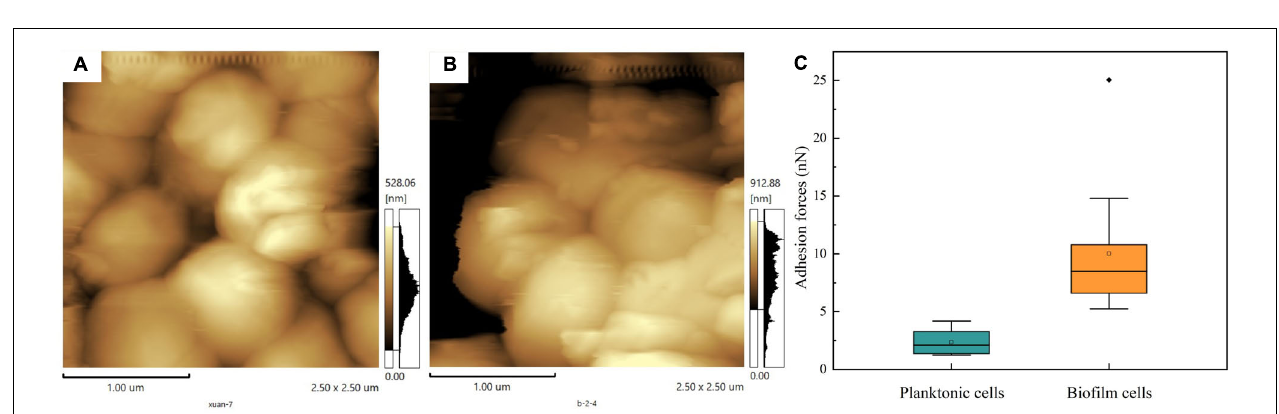
FIGURE 5 | Cell surface properties and LDH activities. (A) Surface charges of planktonic and biofilm cells. (B) Contact angles of planktonic and biofilm cells. (C) Zeta potentials of planktonic and biofilm cells. (D) LDH activities of planktonic and biofilm cells. Asterisk indicates significantly different ( p < 0.05).